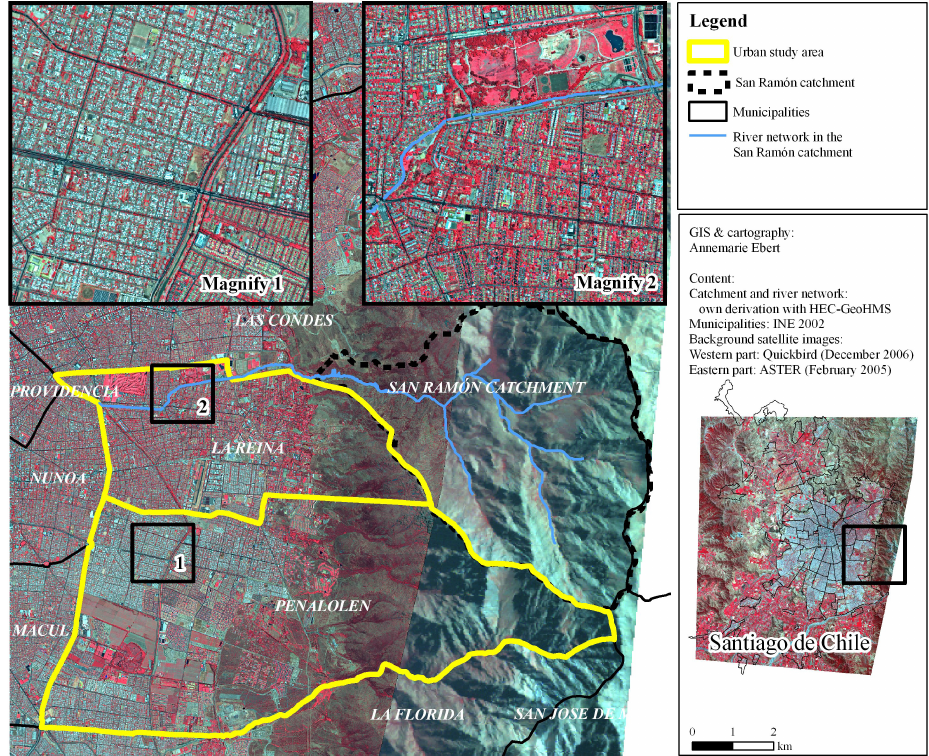
Fig. 1. Location of the study